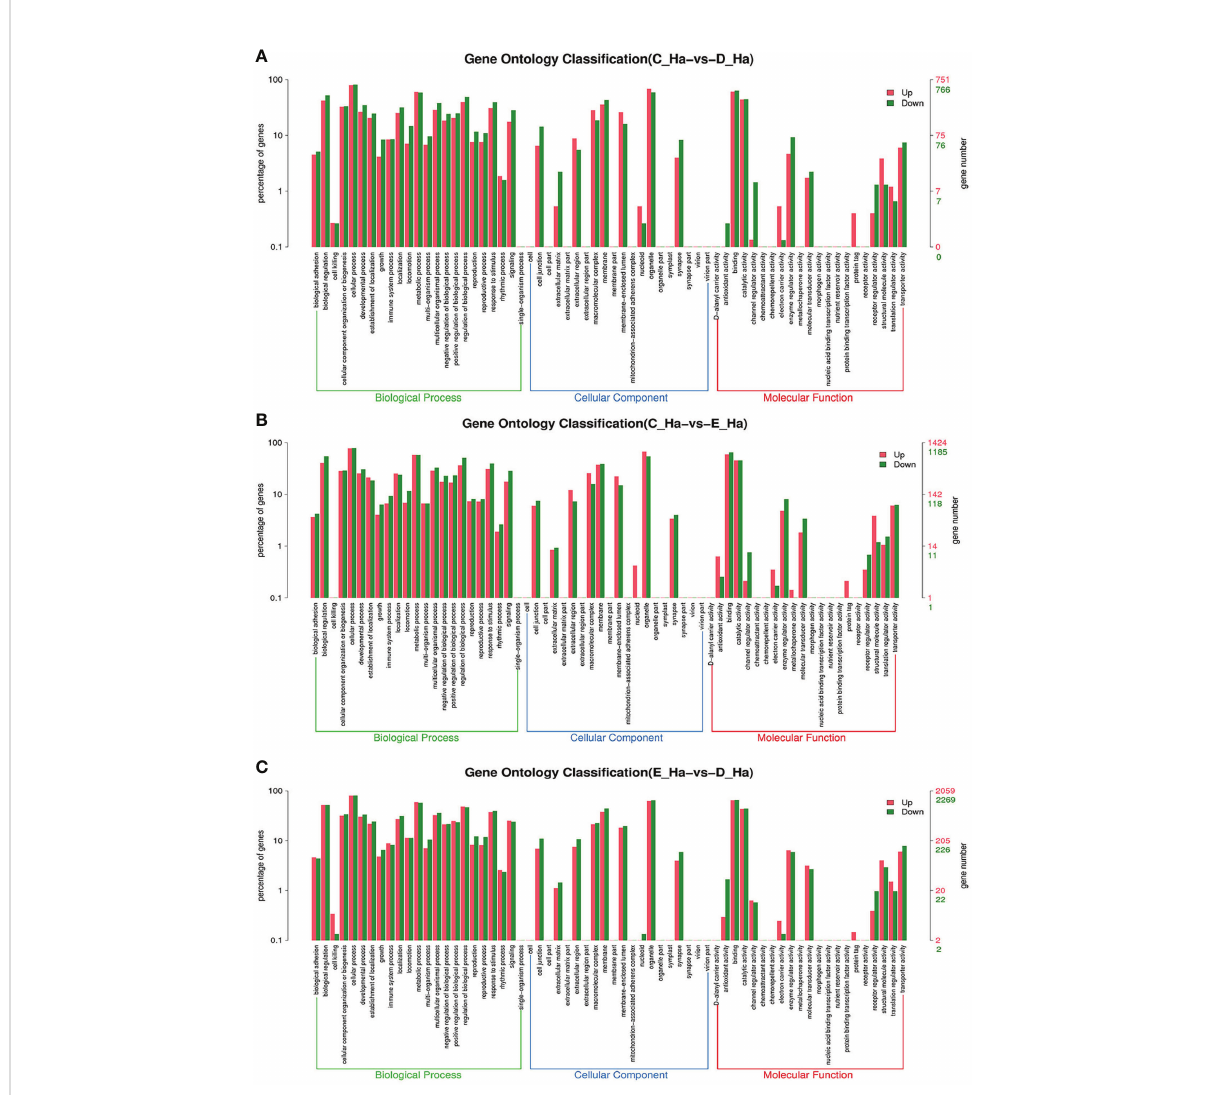
FIGURE 4 GO enrichment analyses of differentially expressed genes (DEGs) in hemolymph transcriptome. Notes: (A) Comparison between C-Ha and D- Ha; (B) comparison between C-Ha and E-Ha. (C) Comparison between E-Ha and D-Ha. Notes: (1) C-Ha: hemolymph from inter-molt; D-Ha: hemolymph from per-molt; E-Ha: hemolymph from ecdysis. (2) Red columns indicate GO item entries enriched by upregulated differentially expressed genes; green columns indicate GO item entries enriched by downregulated differentially expressed genes (3). The x -axis shows the item name between two stages, whereas the y -axis represents the number of genes and their percentage of the corresponding